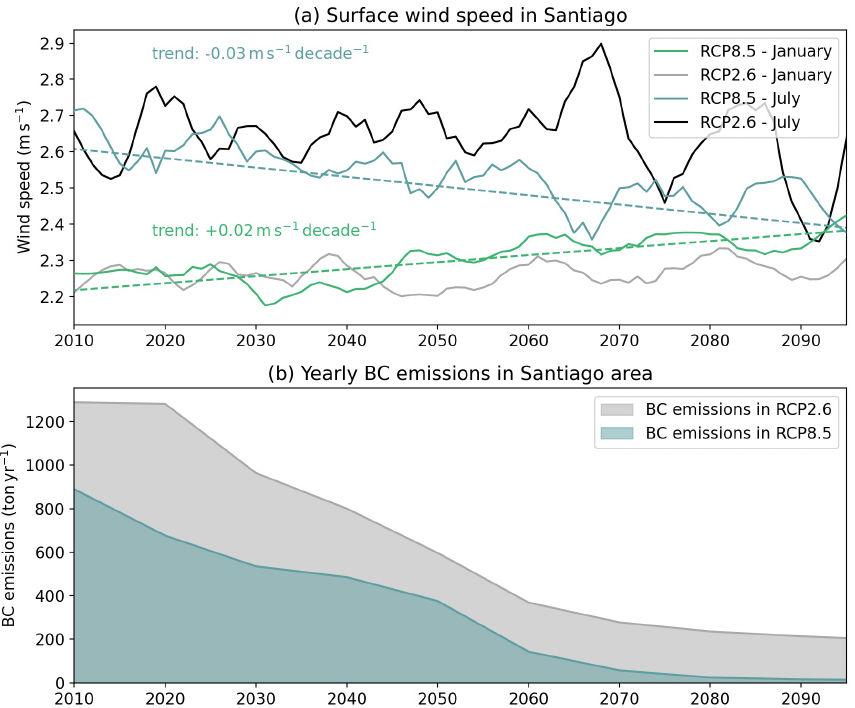
Figure 10. (a) Times series of future monthly surface wind speed in Santiago under scenarios RCP8.5 (blue/green) and RCP2.6 (black/gray) for the months of July/January. Ensemble mean of six model realizations. Trends significant at the 99% level based on a Mann–Kendall test are shown as a dashed line. Data from CORDEX-CORE taken at the grid point 33.5 ◦ S, 70.65 ◦ W. (b) BC emission scenarios for Santiago under the RCP8.5 (blue) and RCP2.6 (gray) scenarios. Data from the RCP database, averaged over the grid points between 33.25 and 33.75 ◦ S and 70.25 and 71.25 ◦